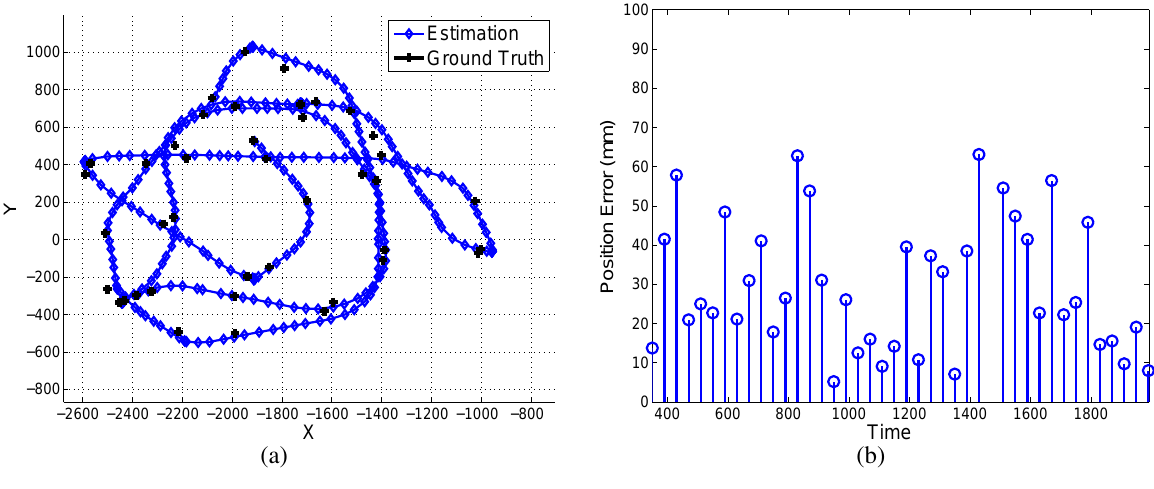
Figure 16. Occlusions and its influence in the localization